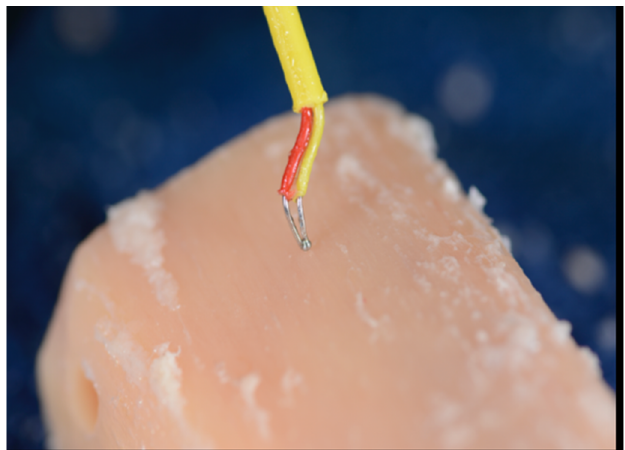
Figure 6. The initial temperature was recorded holding the K-Type thermocouple probe against the bony outer cortical layer (Step 1) [24].